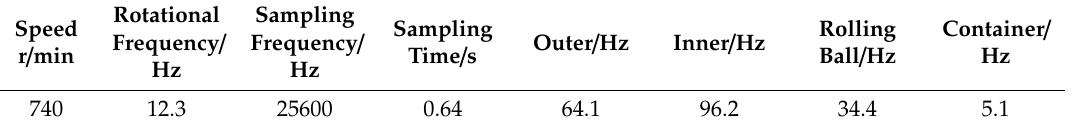
Table 3. Experimental parameters and failure